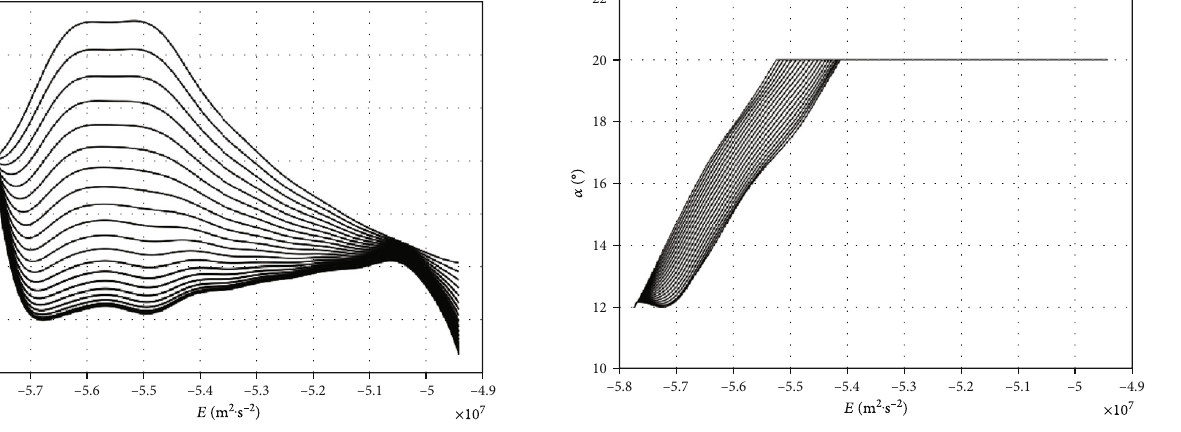
Figure 21: Angle of attack pro fi les for Case